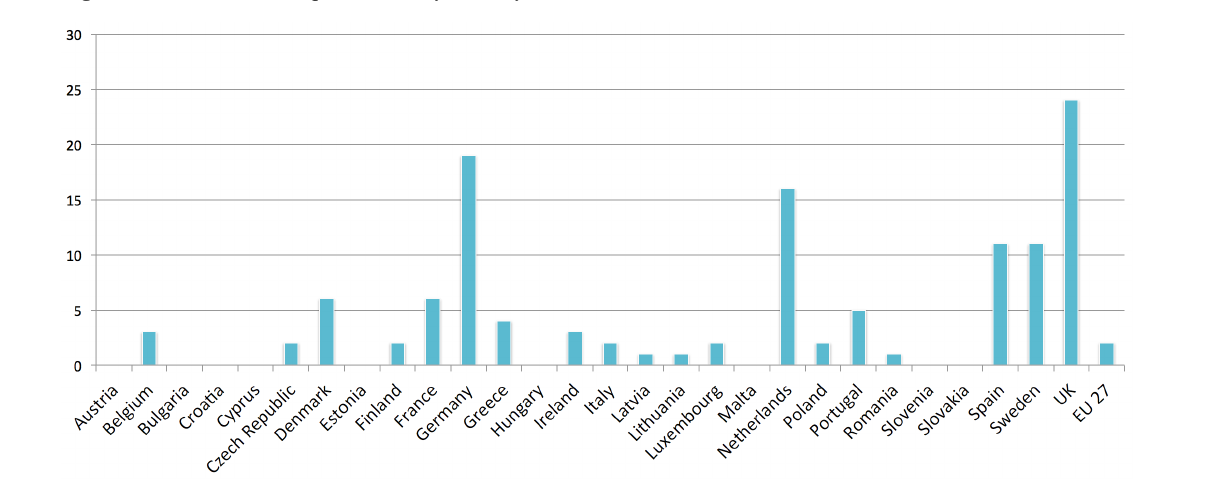
Fig. 4 . Number of studies per case study country.